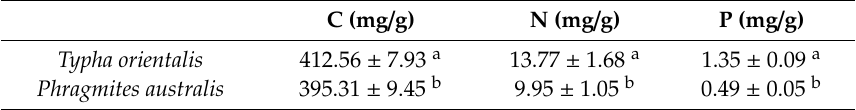
Table A2. The initial contents of C, N, and P of plant materials (mean ± standard deviation, n = 8).